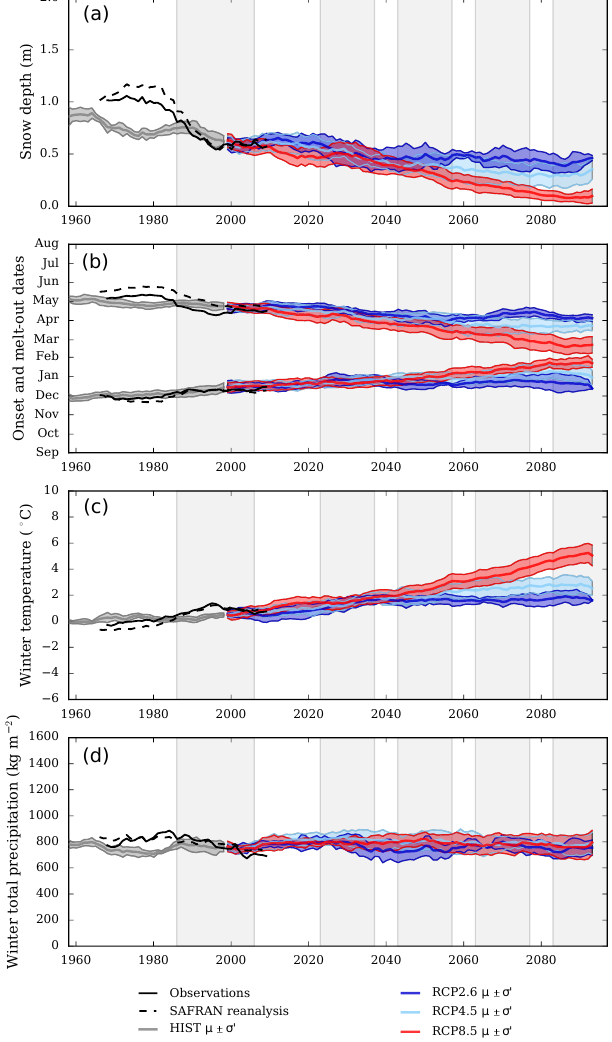
Figure 5. Ensemble spread in 15-year running mean ( µ ± σ (cid:48) ) of all GCM–RCM pairs for each scenario (HIST, RCP2.6, RCP4.5 and RCP8.5), along with 15-year running means of observations (1960– 2016) and SAFRAN-Crocus runs (1958–2016) at CDP, for (a) SD, (b) SOD and SMOD, (c) T , and (d) P . Light grey bars indicate the reference period 1986–2005 and the time slots used in Tables 2–4 and S1–S2.